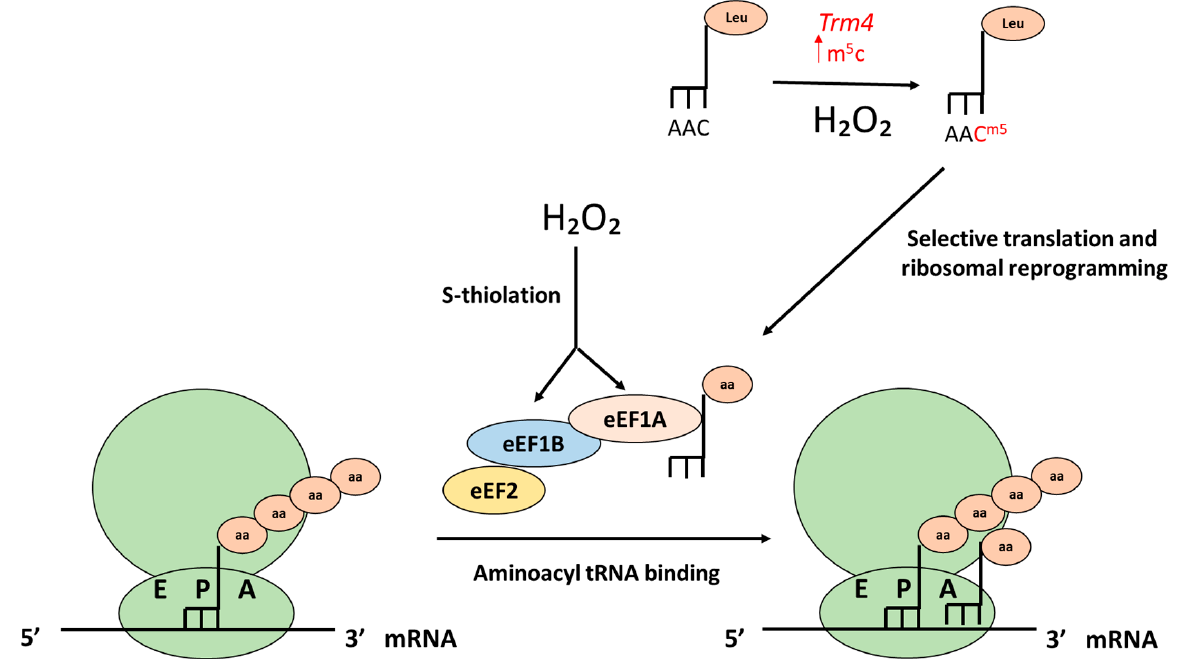
Figure 4. Effects of H 2 O 2 on translation elongation. In yeast, eIE1A and eIE1B can be modified by protein S-thiolation in response to high concentrations of H 2 O 2 . Increase in the methylation in the wobble base 5-methyl-C (m 5 c) at position C34 of tRNA LEU(CAA) in response to H 2 O 2 enhances the efficiency of translation of genes enriched in the UUG codon (as RPL22A and RPL22B ) and causes a change in ribosome composition.